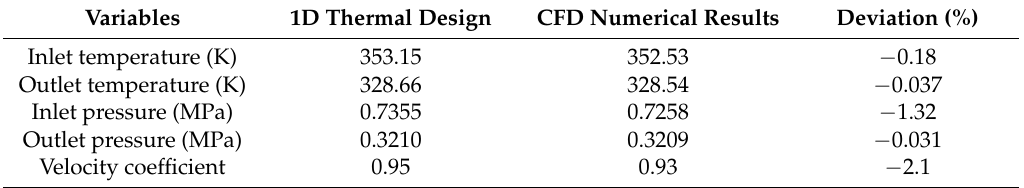
Table 2. Comparison of 1D thermal design and numerical 2D turbulent